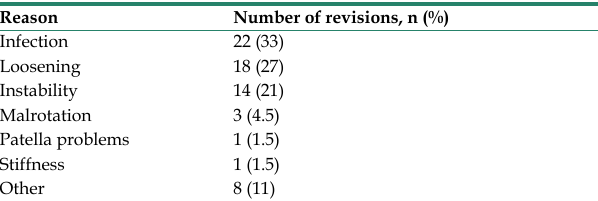
Table 3. Reasons for revision in 67 revision TKAs Reason